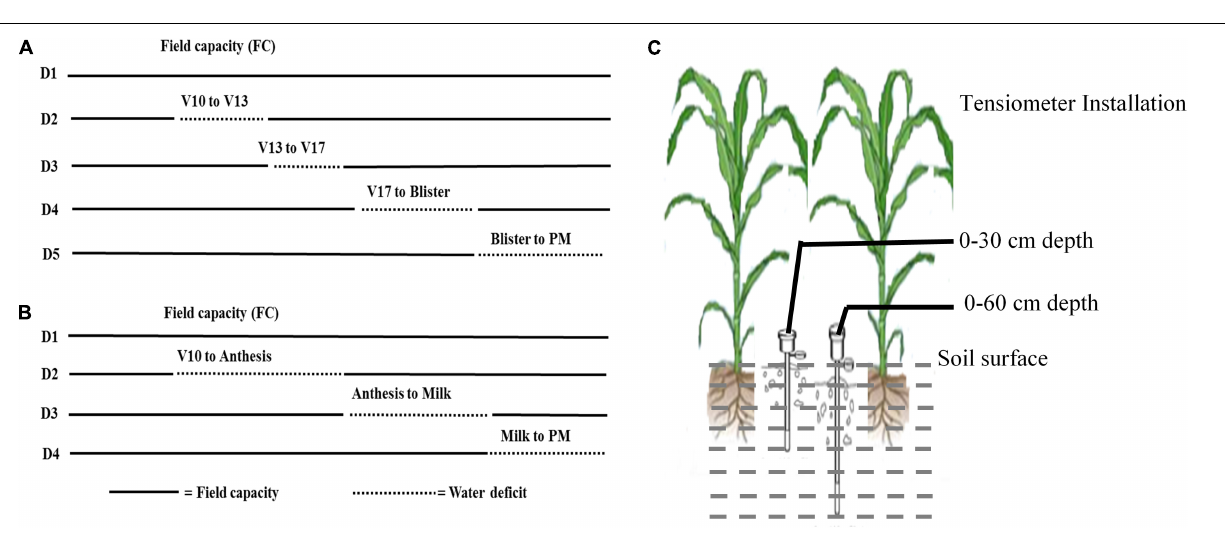
FIGURE 2 | Five water regimes imposed at different growth stages of maize in experiment I (A) and four water regimes at different growth stages of maize in experiment II (B) . Tensiometers were installed at 0–30 and 0–60 cm depth to monitor soil water potential (C) . Sample (-) soil moisture at FC ( < –40 KPa) and (—) indicates the period of water